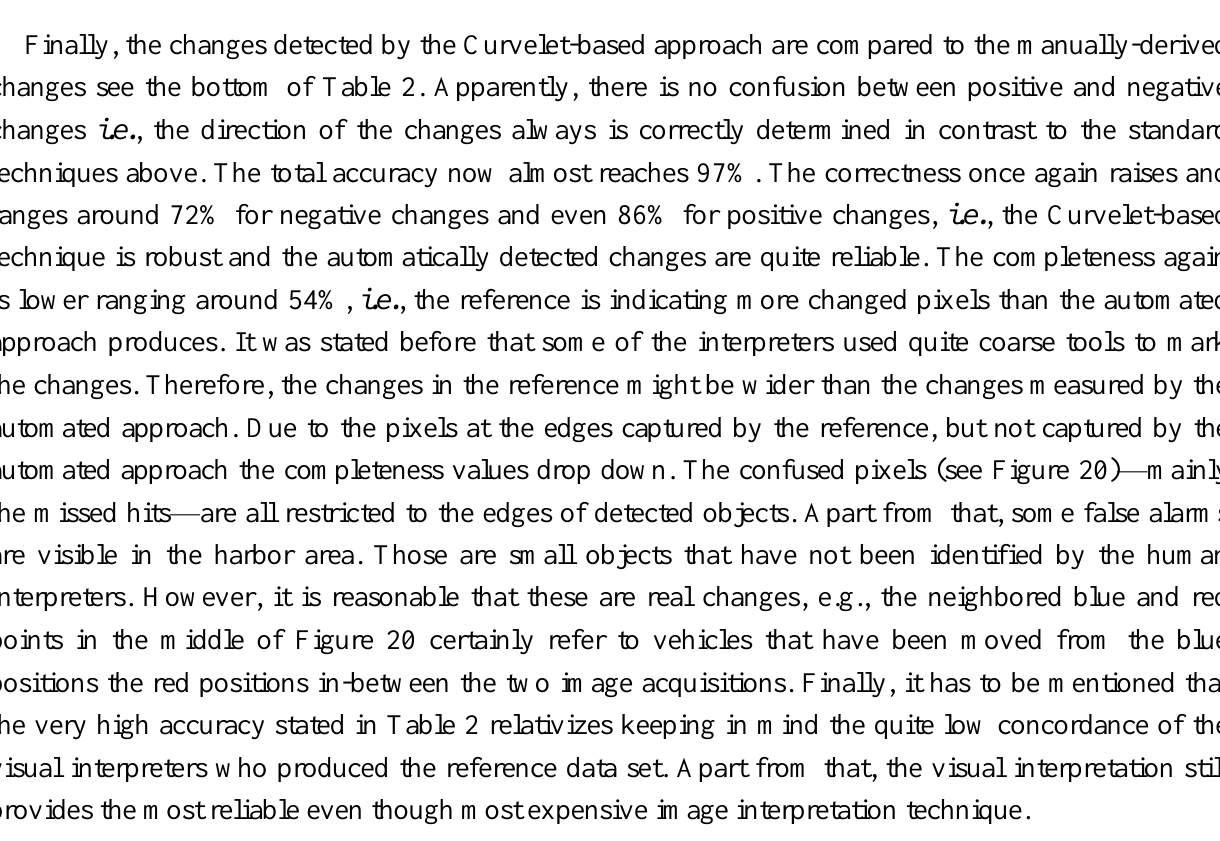
Figure 20. Location of the confusion matrix elements for the change in amplitude using our Curvelet-based